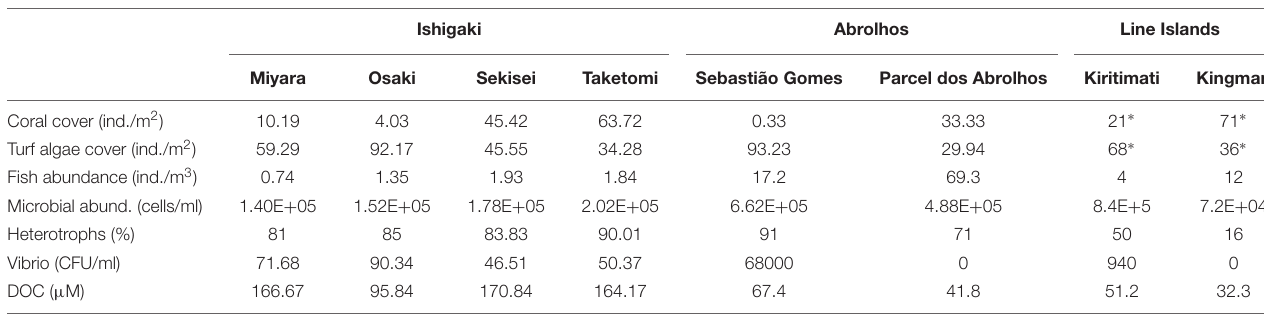
TABLE 1 | Ishigaki Island reef sites compared with other reefs.